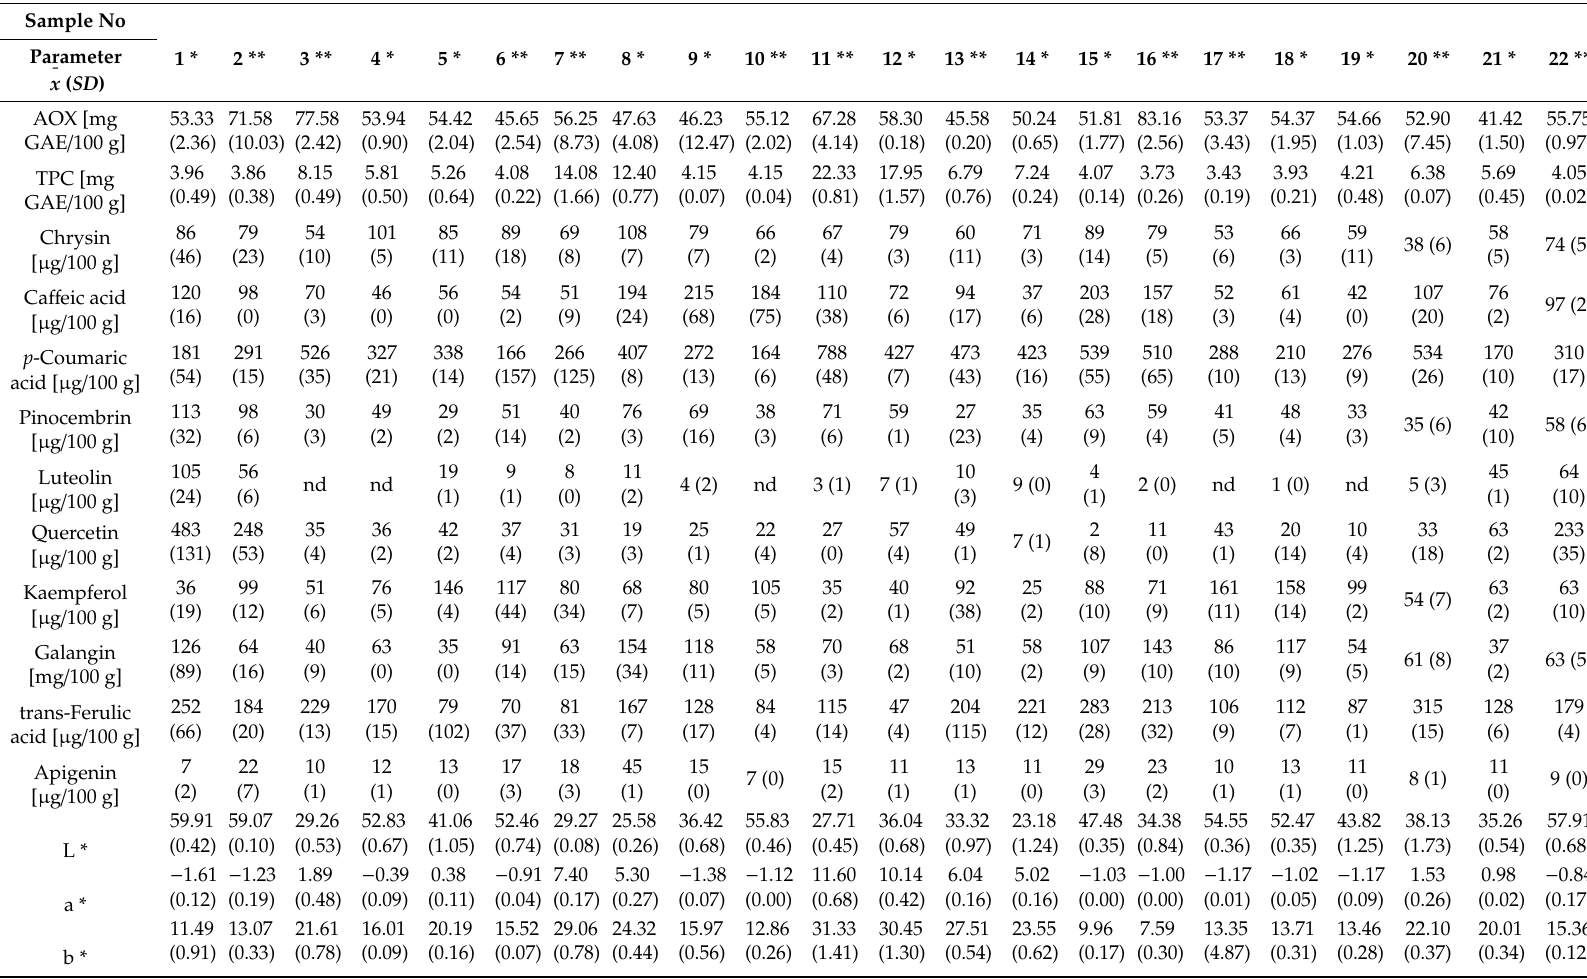
Table 2. Phenolic compound profile, total phenolic content (TPC), total antioxidant activity (AOX), and color parameters (L*, a*, b*) of some selected honey